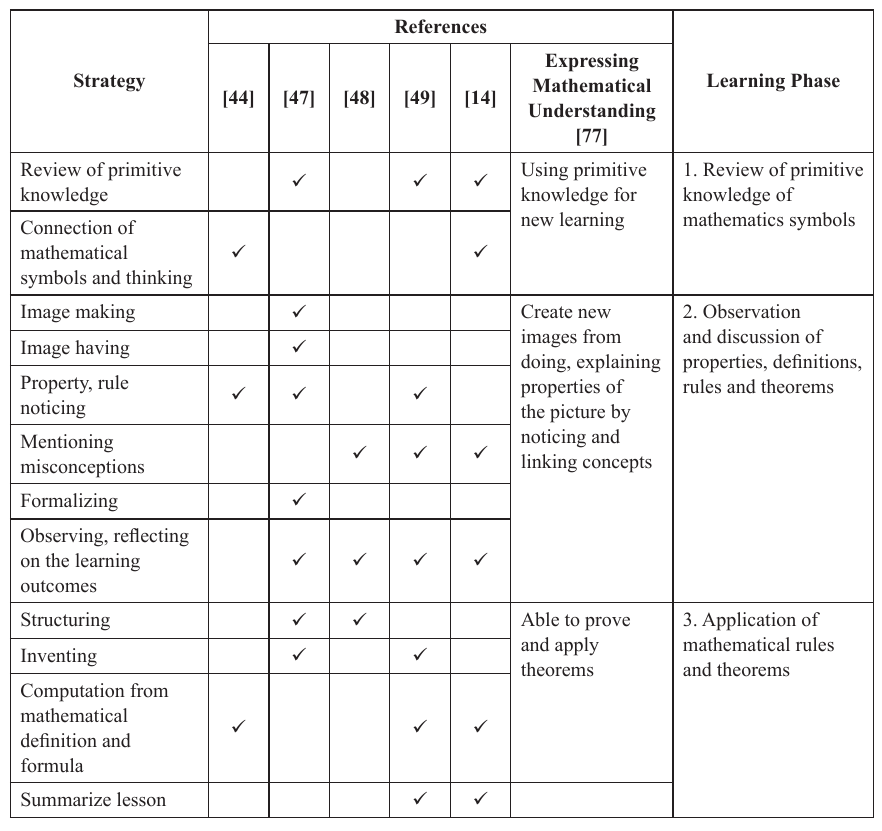
Table 1. The analysis and synthesis of approaches for developing conceptual understanding in